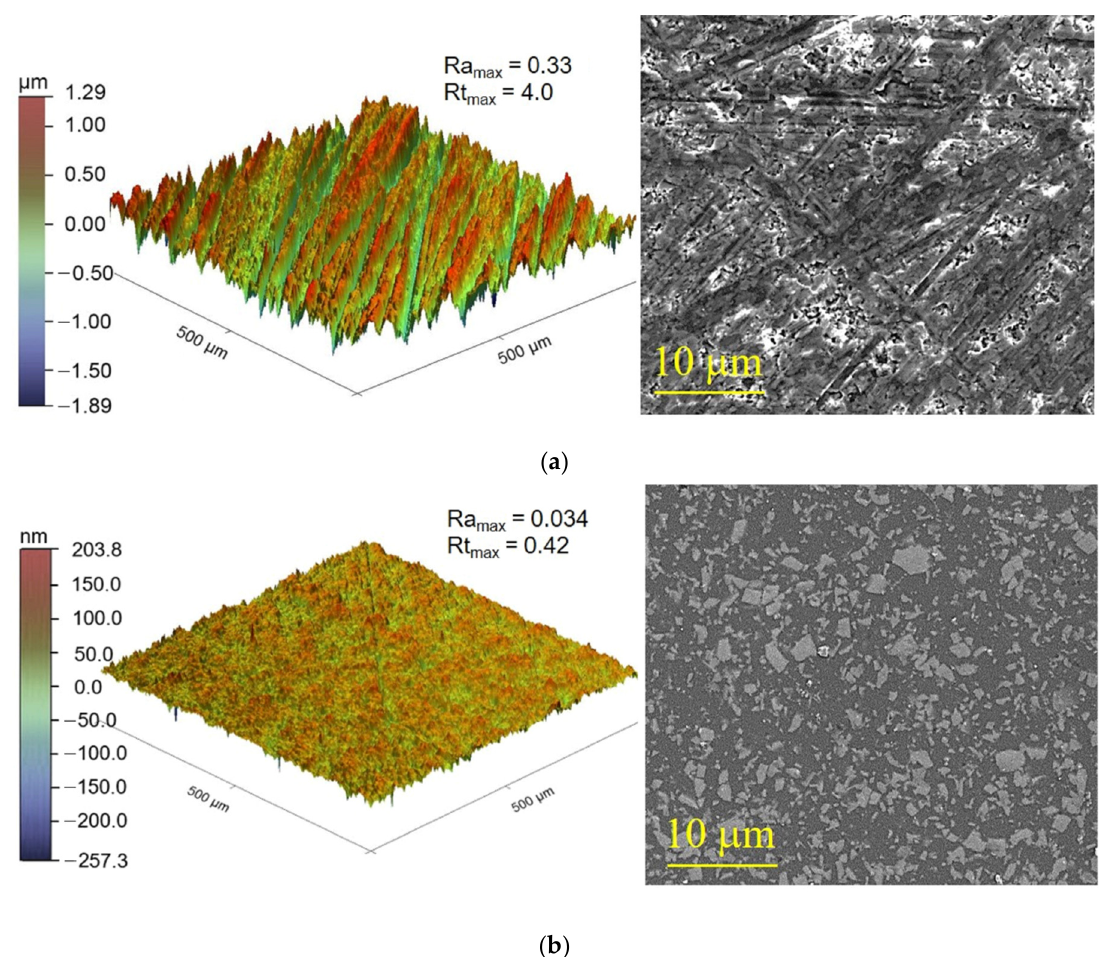
Figure 4. 3D profilograms ( left ) and SEM images ( right ) of the microstructure of the surface layer of Al 2 O 3 +TiC ceramic inserts after diamond grinding ( a ) and after diamond grinding, lapping and polishing ( b ). Table 3. Characteristics of the surface layer of Al 2 O 3 +TiC ceramic inserts after various types of abrasive treatments.